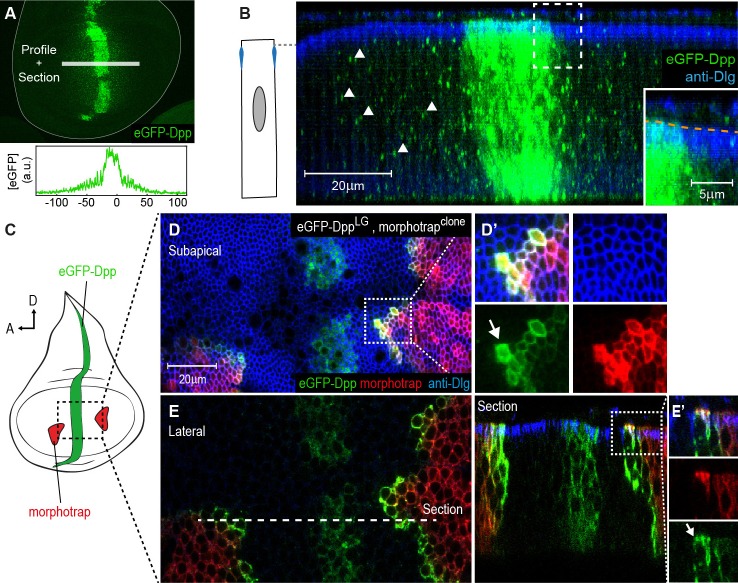
The Dpp morphogen spreads in the apical and basolateral compartment.(A) Wing disc expressing eGFP-Dpp in the central Dpp stripe and eGFP fluorescence profile (bottom). (B) Optical cross-section of a wing disc as shown in (A) additionally stained for Dlg (blue). eGFP-Dpp is prominently observed in spots (arrowheads) along the lateral axis of the disc but not in the wing disc lumen (see magnified insert). (C) Scheme of morphotrap expression in clones and eGFP-Dpp in the central dpp stripe. (D) Subapical projection of a wing disc expressing eGFP-Dpp in the dpp stripe and two lateral morphotrap clones. Magnifications to the right show apical eGFP-Dpp immobilization on the proximal surface of morphotrap clones. (E) Lateral projection of the wing disc shown in (D). An optical cross-section to the right shows low level apical (also see arrow in magnification in [E’]) and high level basolateral immobilization of eGFP-Dpp.